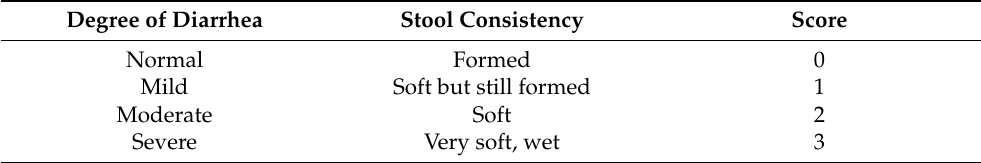
Table 2. Scoring system for calculating diarrhea 1